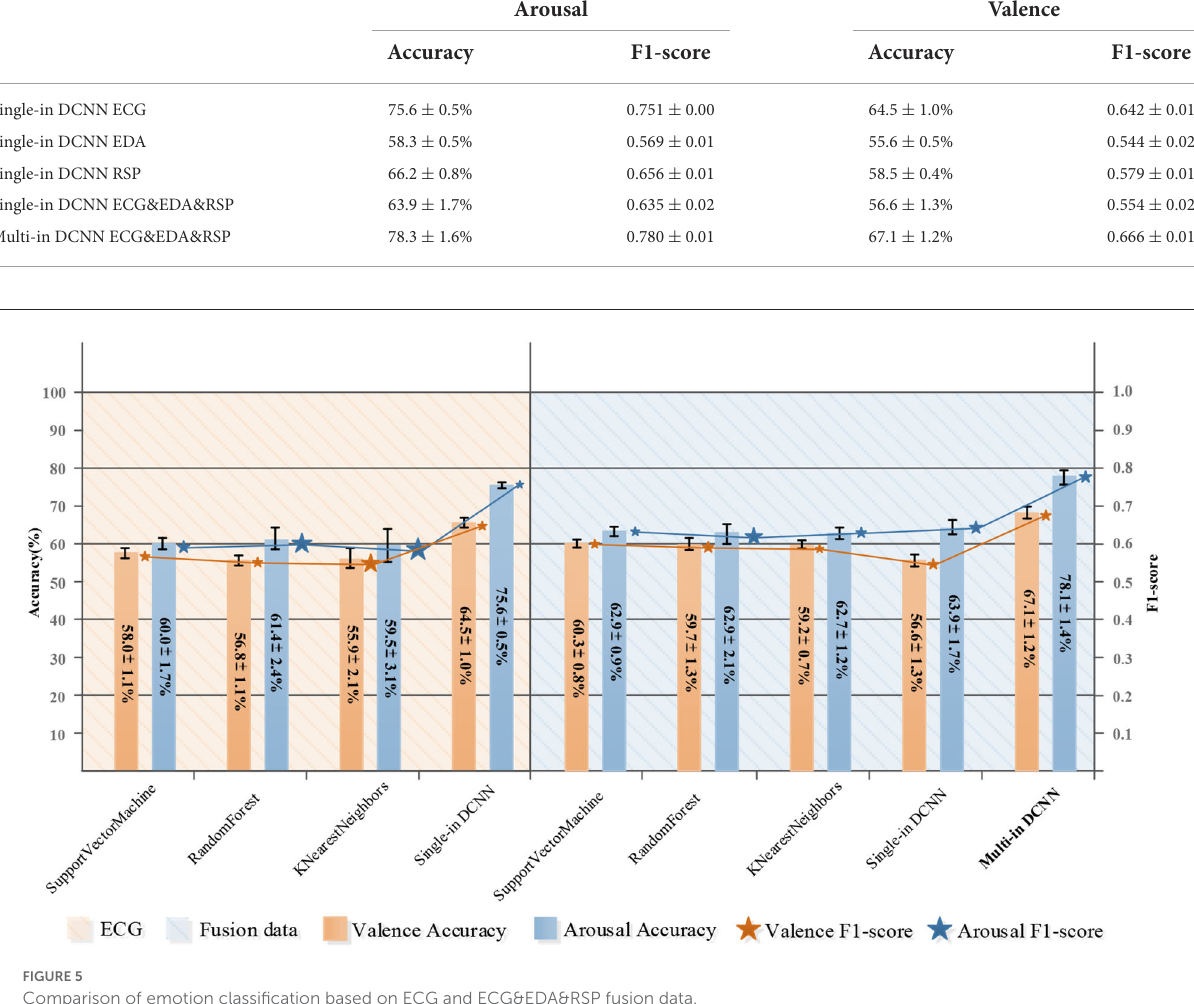
TABLE 7 Results of using our proposed methods in our dataset.